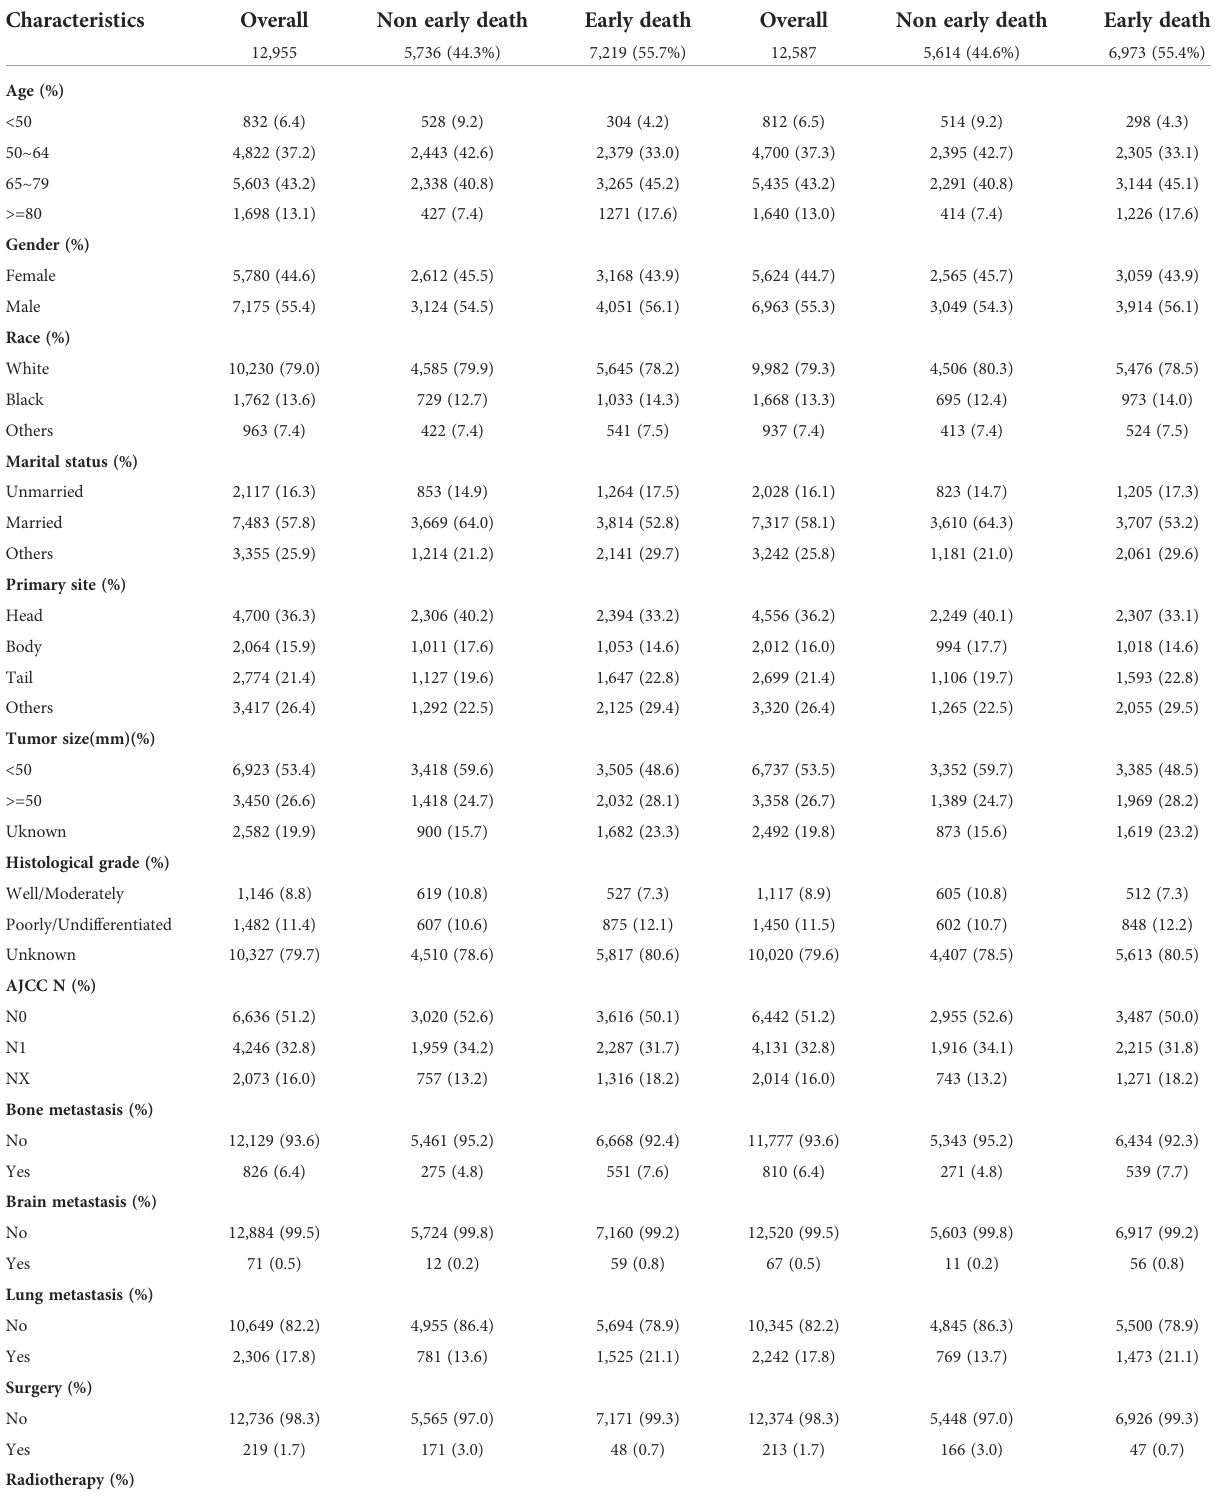
TABLE 1 Demographic and tumor characteristics of patients with PCLM in SEER